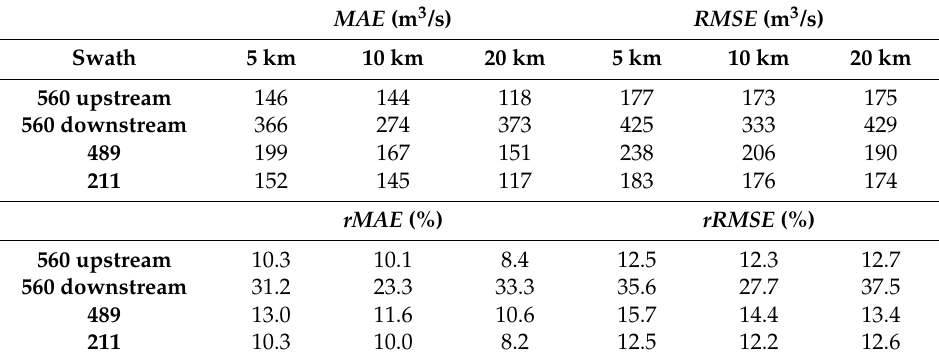
Table 3. Mean values of RMSE and MAE (m 3 /s), rRMSE and rMAE (%) for each swath considering all overpasses over the Po River during the reference